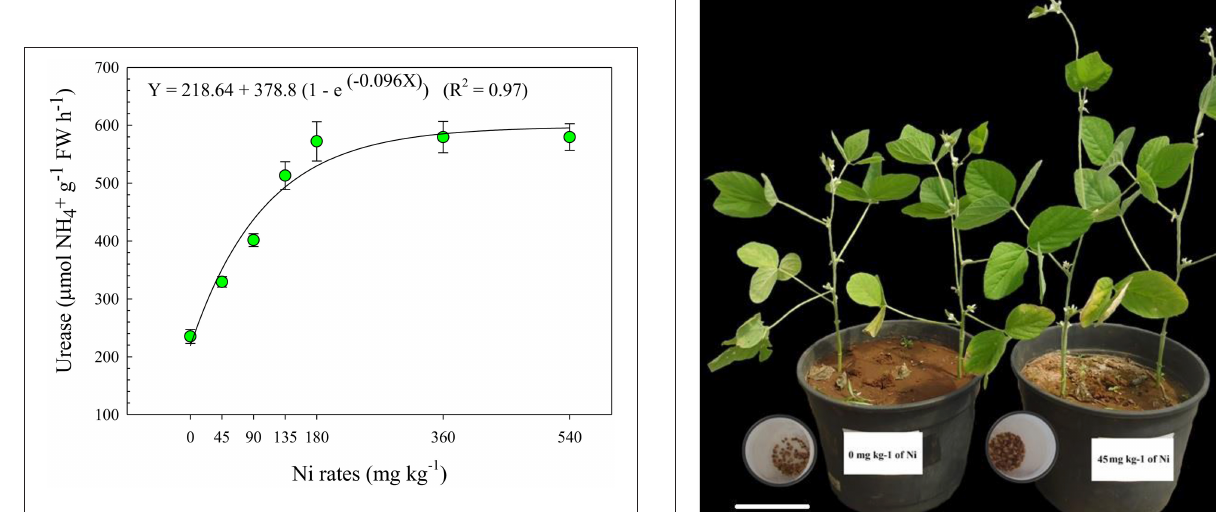
FIGURE 4 | Urease activity taken on the leaves of soybean cultivar BMX Potência RR , collected at R1 phenological stage ( Fehr et al., 1971), as related to Ni seed treatments (rates). The assessments were taken using the middle third of the diagnostic leaf of plants in phenological stage R1, and the average was computed of four replicates per treatment. Mean ± SD. (Fisher Test, p < 0.01 ).